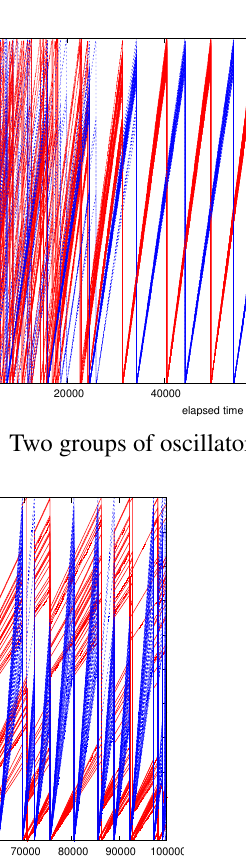
Figure 2. Phase transition in numerical